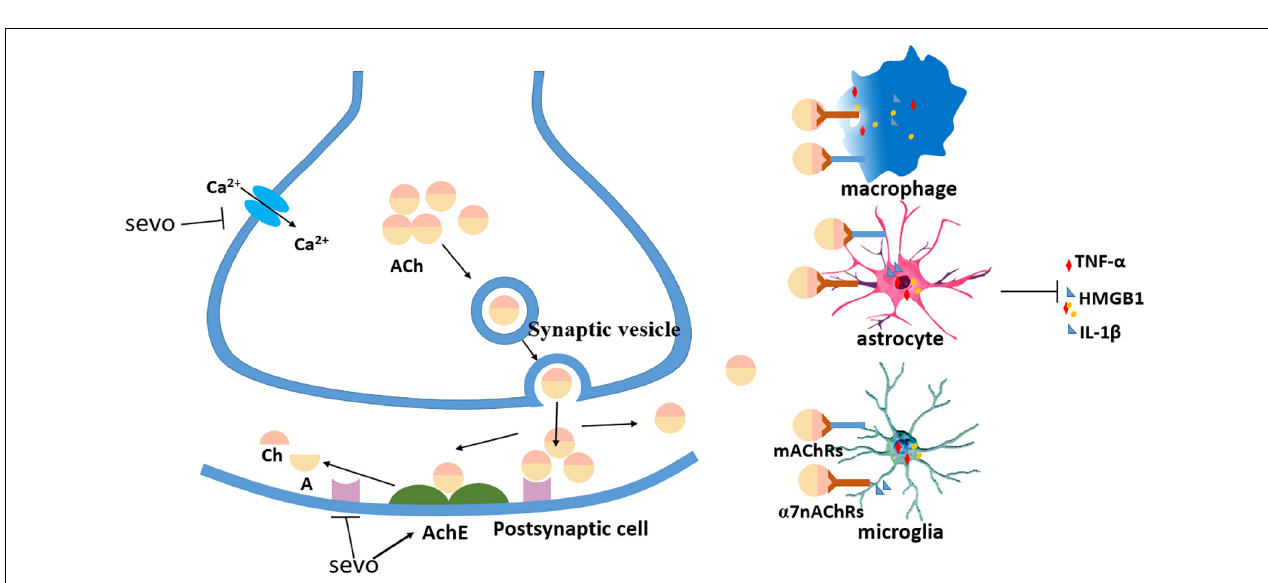
FIGURE 2 | Sevoflurane decreased cholinergic neurotransmission. Sevoflurane partially decreased presynaptic acetylcholine (ACh) by inhibiting calcium currents, sevoflurane decreased postsynaptic ACh by increasing acetylcholinesterase (AChE), and sevoflurane reduced ACh binding with ACh receptors (AChRs) on the immune cells to inhibit the release of proinflammatory